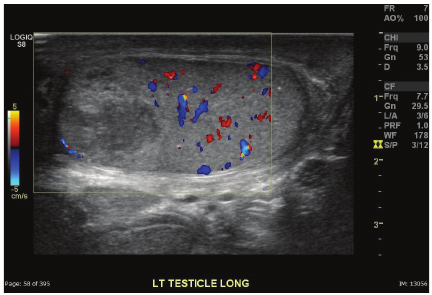
Figure 2: Follow-up color-Doppler ultrasound image shows inter- val enlargement of the testicular lesion.